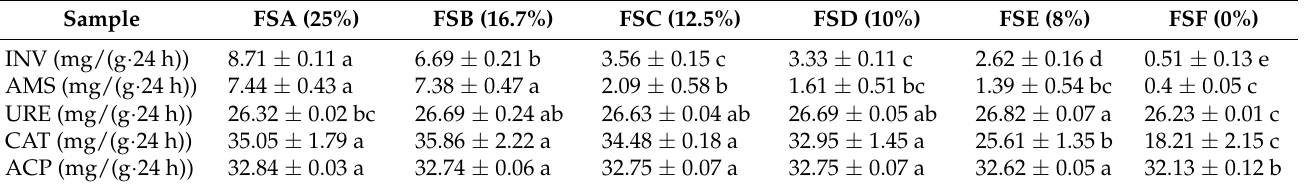
Table 2. Enzyme activity of saline-alkali soil improved by addition of different amounts of GLR organic fertilizer. For each row, the means ± SD with different letters were significantly different between treatments ( p < 0.05, using the HSD